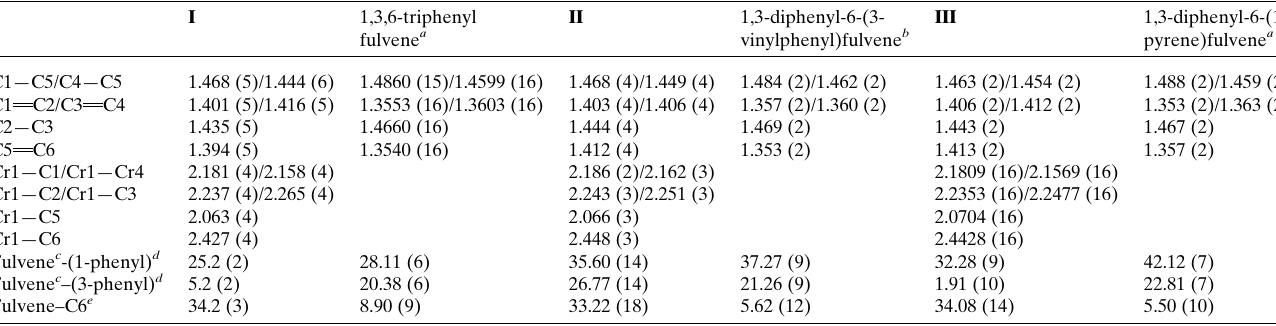
Table 1 Selected geometric parameters (A˚ , (cid:3) ) for I , II , and III and the corresponding fulvenes.